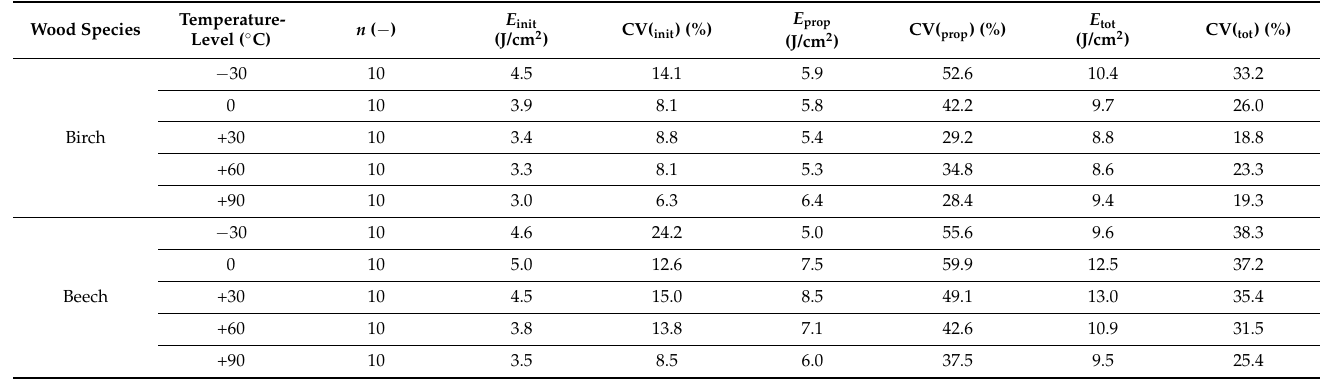
Table 3. Overview of the crack initiation energy, the crack propagation energy, the total energy, mean values and their CVs based on the deceleration method (CV—Coefficient of